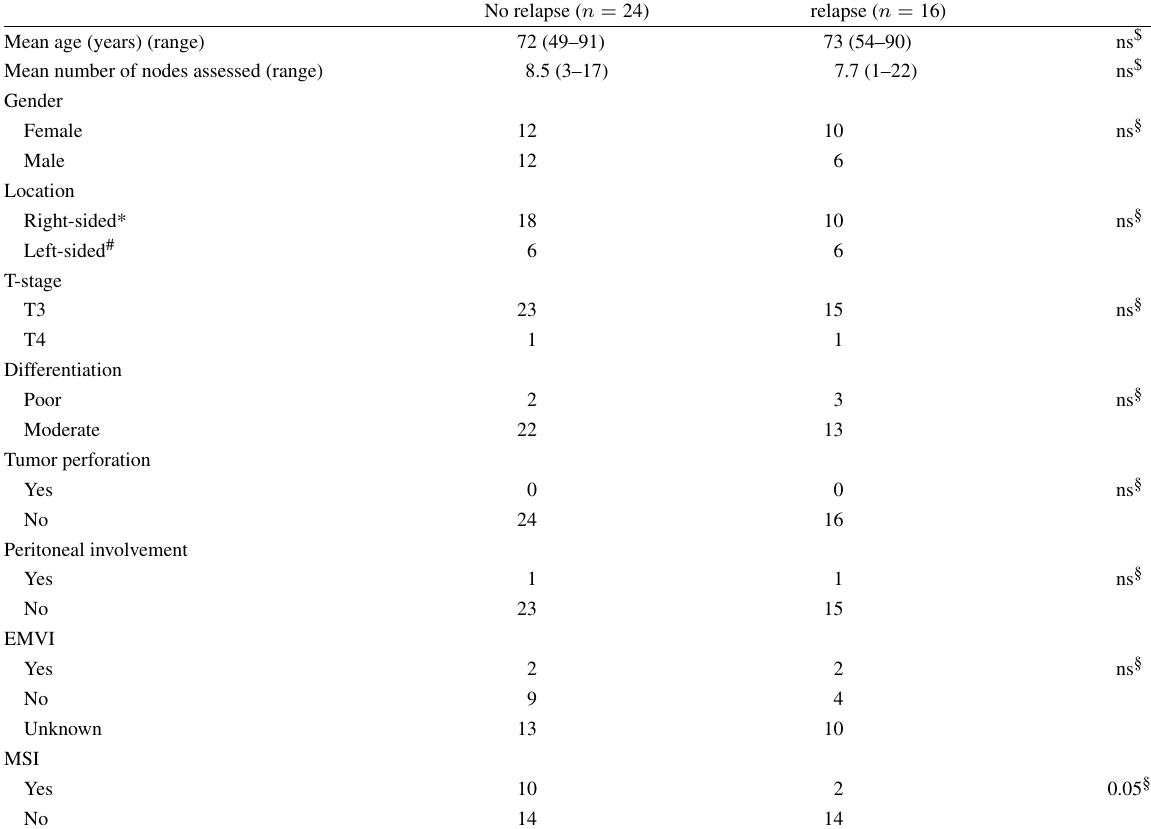
Patients and tumor characteristics of stage II colon cancers ( N =